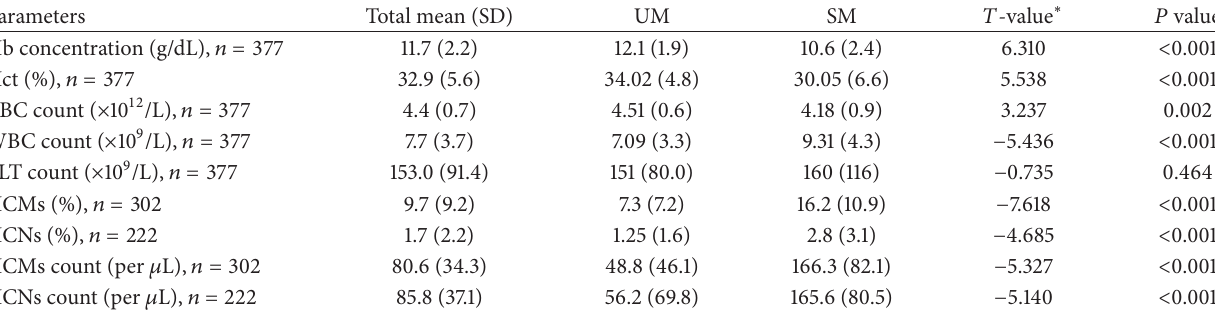
Table 2: Comparison of mean values of hematological parameters and hemozoin-containing leukocytes with malaria severity among the study participants, Pawe General Hospital,